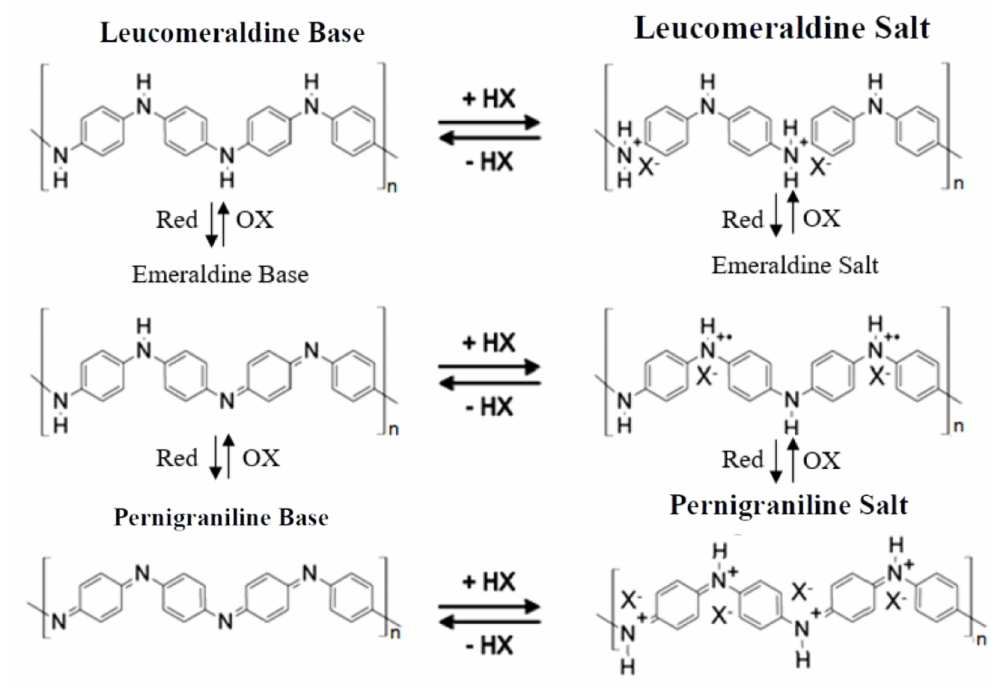
Figure 5. Equilibria of different polyaniline (PANI) states. (X − = Cl − ).